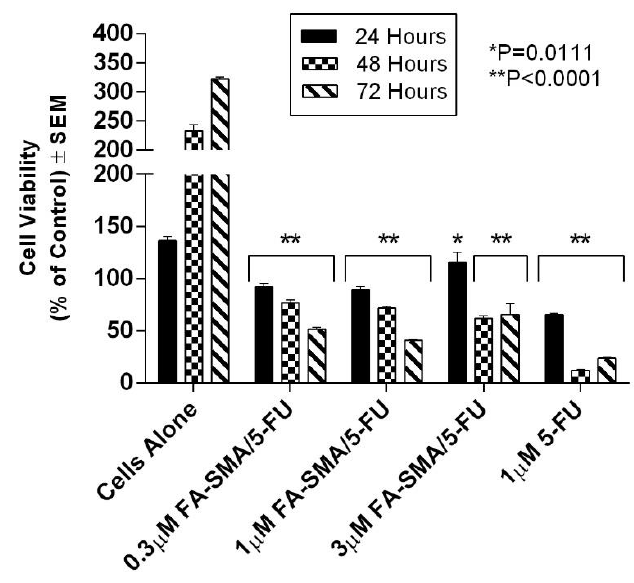
Figure 8. Cell viability of PANC-1 cells at 72 h treated with 0.3 µM FA-DABA-SMA/5- FU, 1.0 µM FA - DABA-SMA/5- FU, 3.0 µM FA -DABA-SMA/5-FU, and 1.0 µM of 5 -FU using the WST-1 assay. 5-FU was encapsulated at maximum loading capacity in each sample. The data represent the mean ± SEM of n = 5 independent experiments.